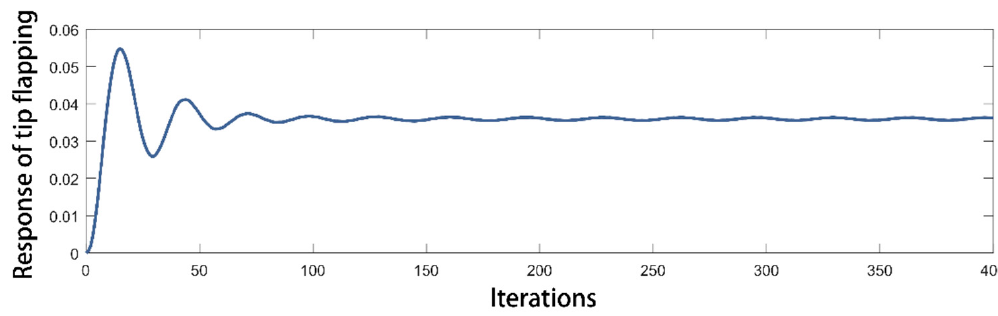
Figure 14. Response of blade tip flapping.